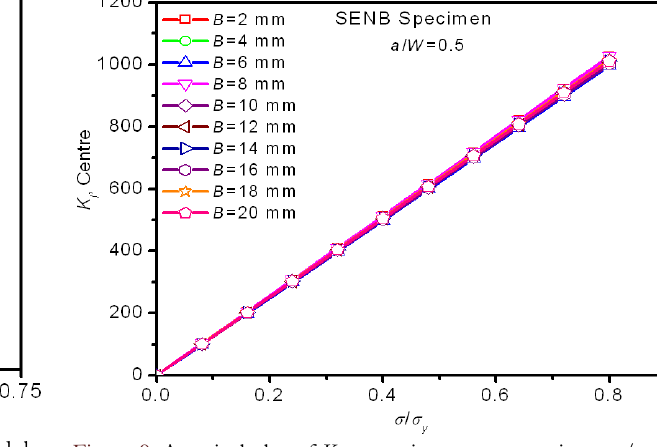
at specimen centre against / I